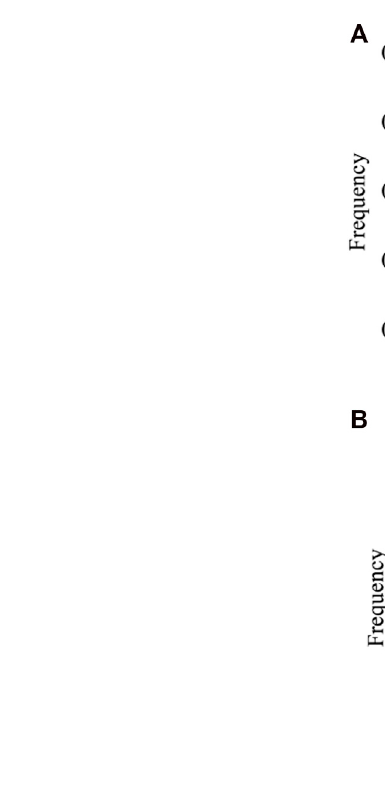
FIGURE 3 Matched rateand Length distributionsdistributionsofdifferentintronoptimal matchedsegments,separately. The X-axisisLength and matchedrate (%)of intron optimal matched segment,separately and the Y-axis represents the Frequency